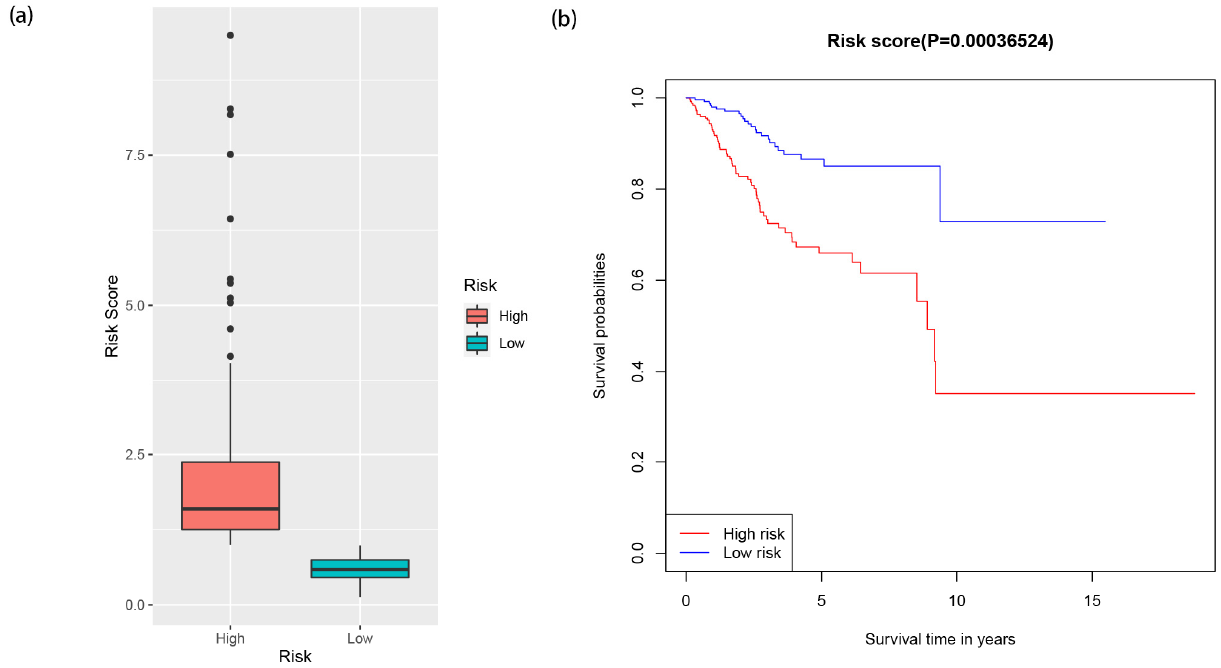
Figure 7. Risk scores of EC patients in high- and low-risk groups. ( a ) The risk scores of EC patients in the high- and low-risk groups displayed by the boxplot. ( b ) Survival analysis of EC patients in high- and low-risk groups.